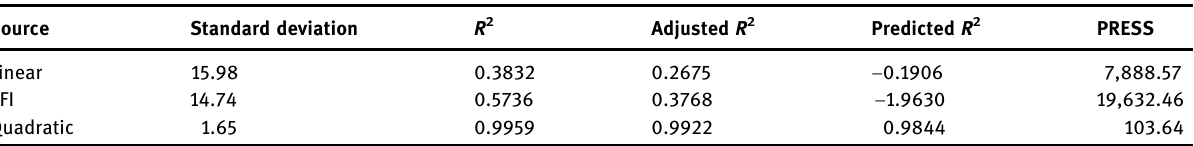
Signi fi cant values, df: degree of freedom, PRESS: sum of squares of prediction error, two factor interaction: